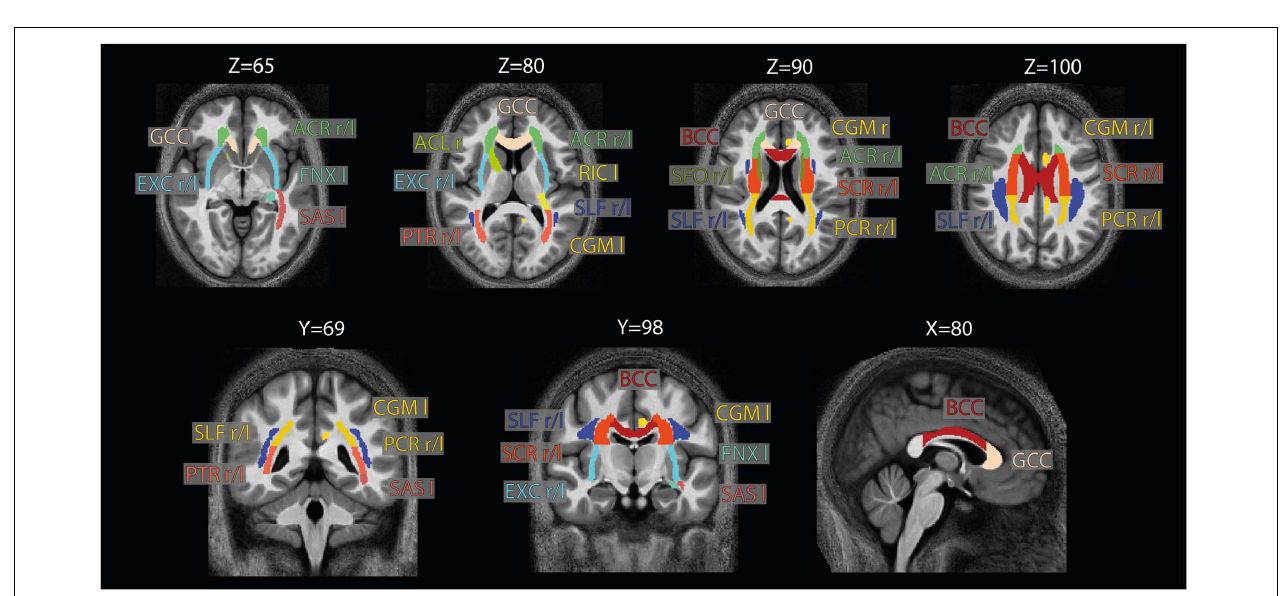
FIGURE 4 | Location of the ROIs used for analysis. The 21 high-SNR ROIs (listed in Table 1 ) are part of the JHU-ICBM-DTI-81 WM atlas (Hua et al., 2008) and are displayed here on the group-averaged normalized MT B1 sat image. Note that for ROI analysis, the ROIs were projected into the native space using the inverse of the combined deformation field.